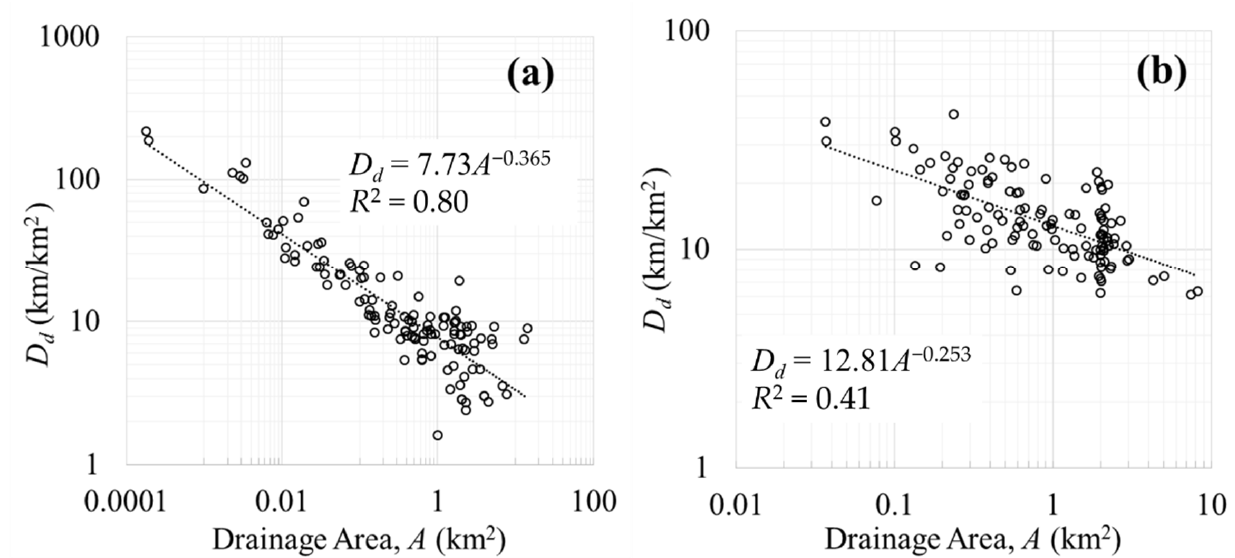
Figure 9. The relationship between drainage density ( D d ) and drainage area: ( a ) 124 watersheds in arid regions from Melton [33] and ( b ) 121 watersheds in humid to arid regions from this study. To investigate the climate effect on the relationship between D d and A , the study watersheds were categorized into two groups: 1) humid ( E P / P < 1) and 2) arid ( E P / P ≥